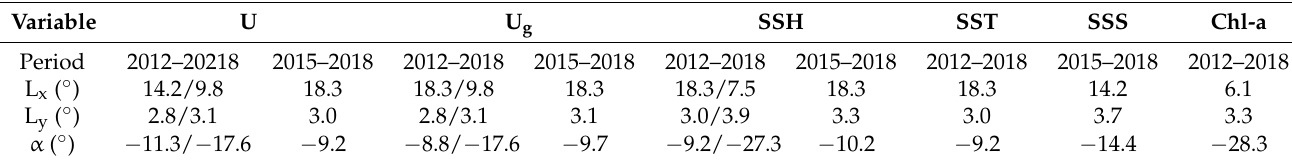
Table 1. Zonal and meridional wavelengths (L x , L y ), and the striation angle ( α ) associated with surface tracers and the dynamical fields determined from 2-D FFT in the ENP (Figure 4). For dynamical fields over the SST/Chl-a record (2012–2018), values on the left/right correspond to the black dashed boxes in Figure 2a/Figure 2e, respectively. Positive/negative α values are